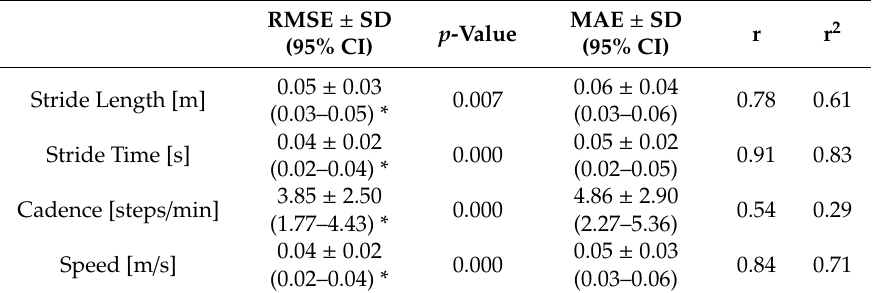
Table 5. Summary of the results of the validation of the feature Set 1 for the THA group. Shown are the RMSE ± SD (95% CI), the MAE ± SD (95% CI), r and r 2 . An asterisk indicates a significant di ff erence between the THA Group and the Control Group. The corresponding p -values are given. RMSE ±